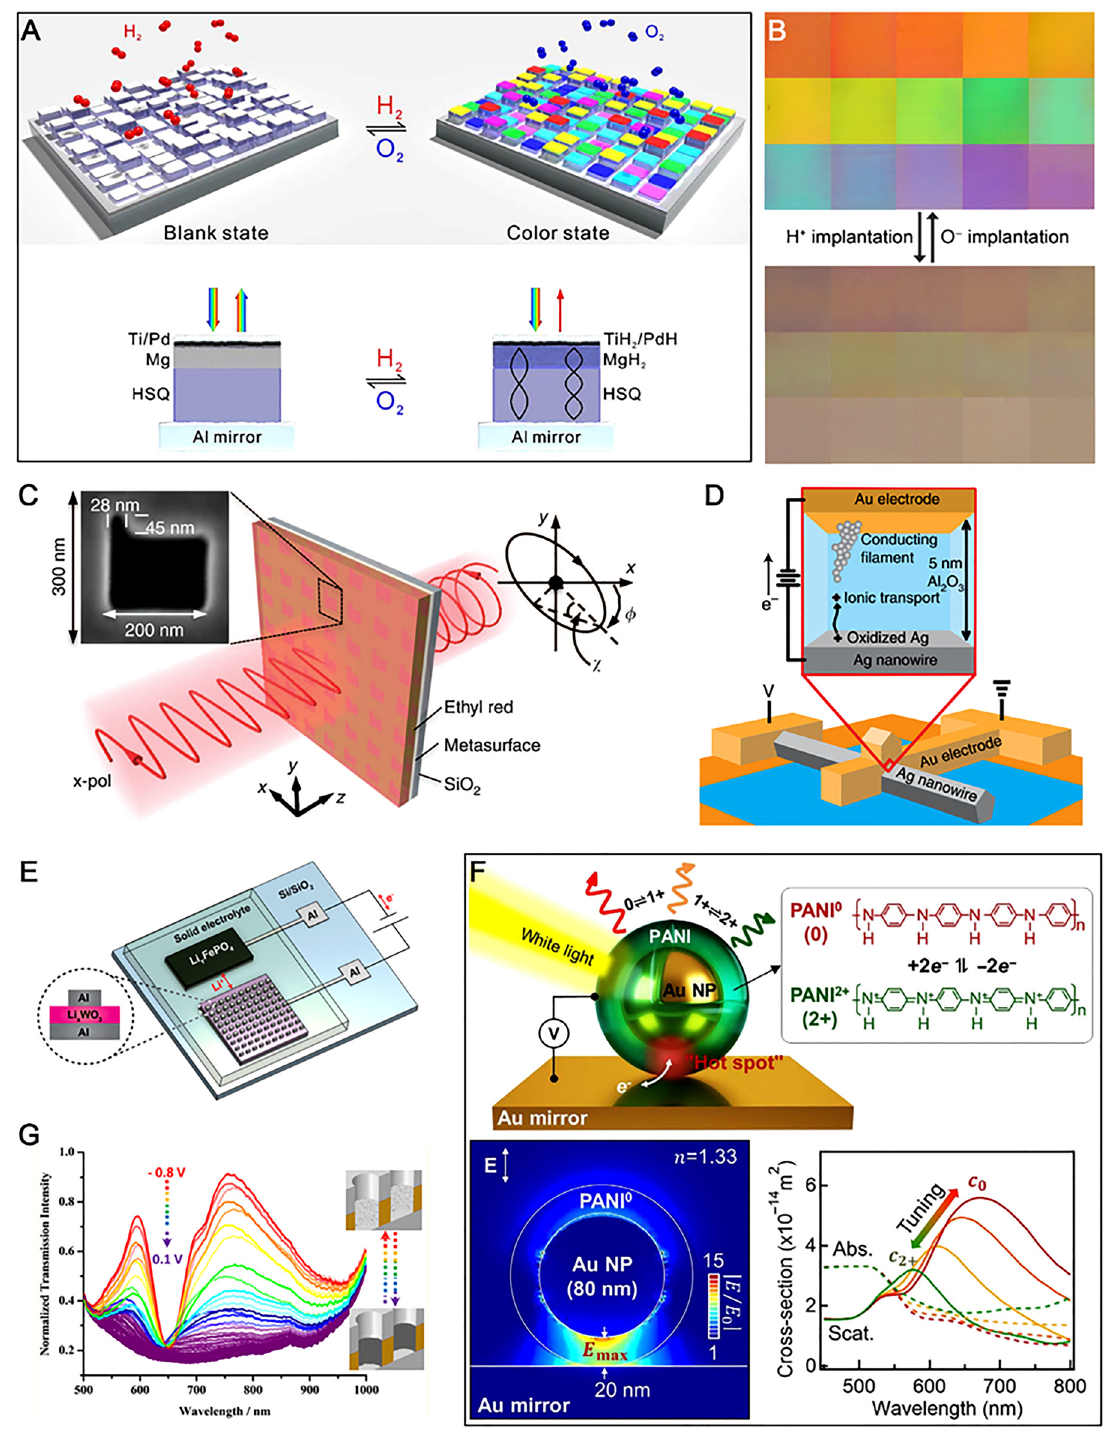
Figure 2: Structures and optical response of metasurfaces tuning by chemical and electrochemical